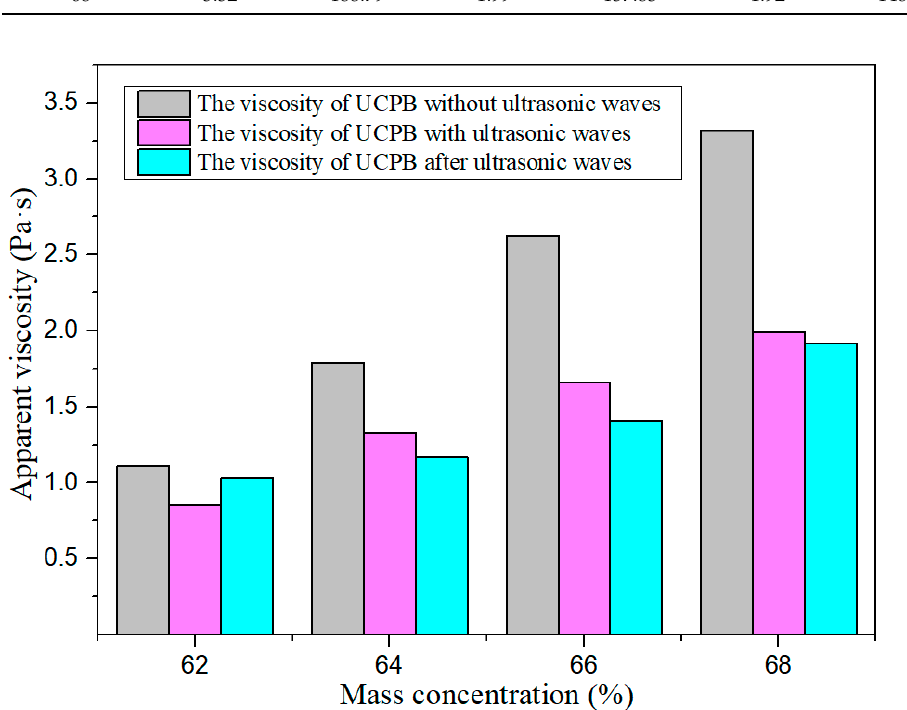
Figure 7. Apparent viscosity vs. mass concentration curves of UCPB.